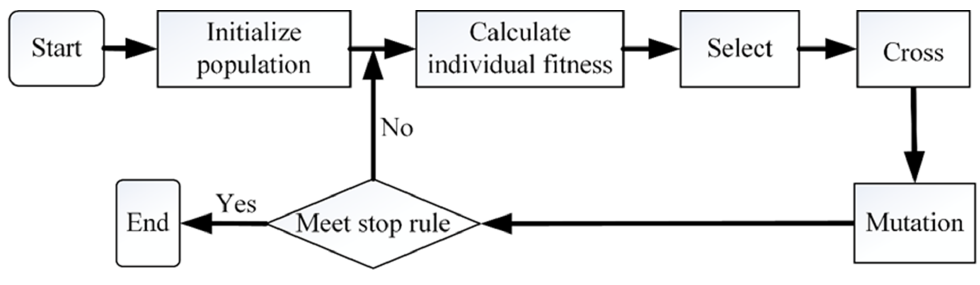
Figure 7. Flow chart of genetic algorithm.